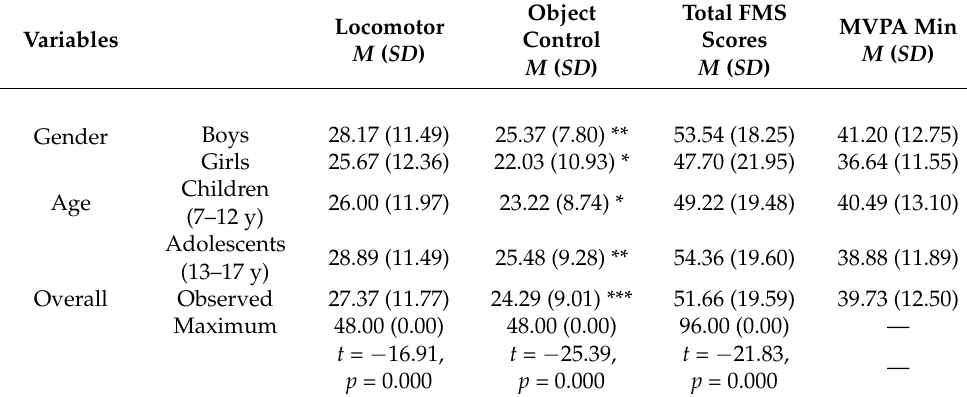
Table 3. FMS scores and MPVA times for children and adolescents with